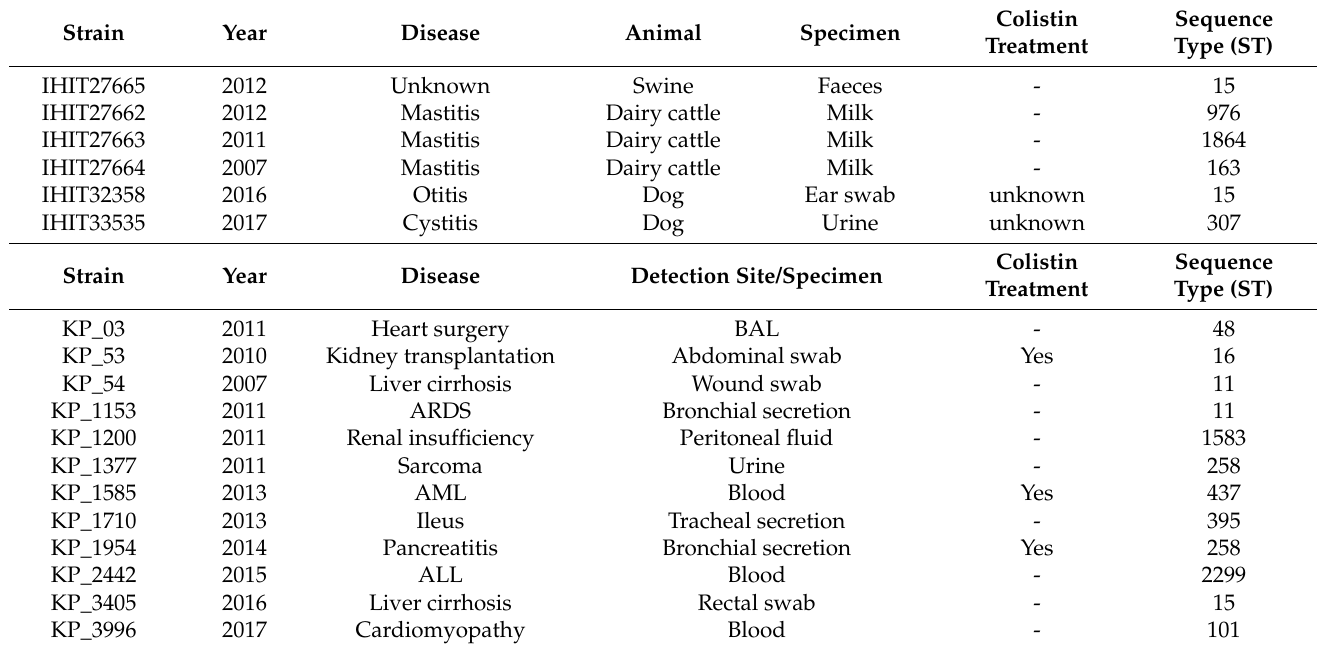
Table 1. Epidemiological data of K. pneumoniae isolates resistant to COL obtained from veterinary and human